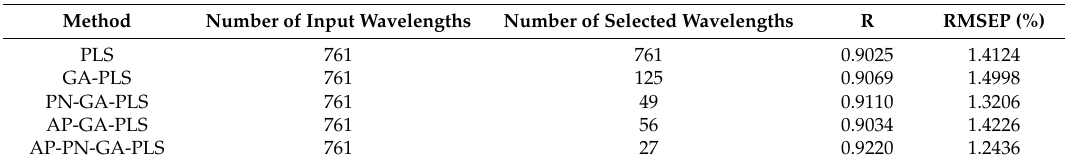
Table 6. The average values of the number of selected wavelengths, R, and RMSEP using PLS,